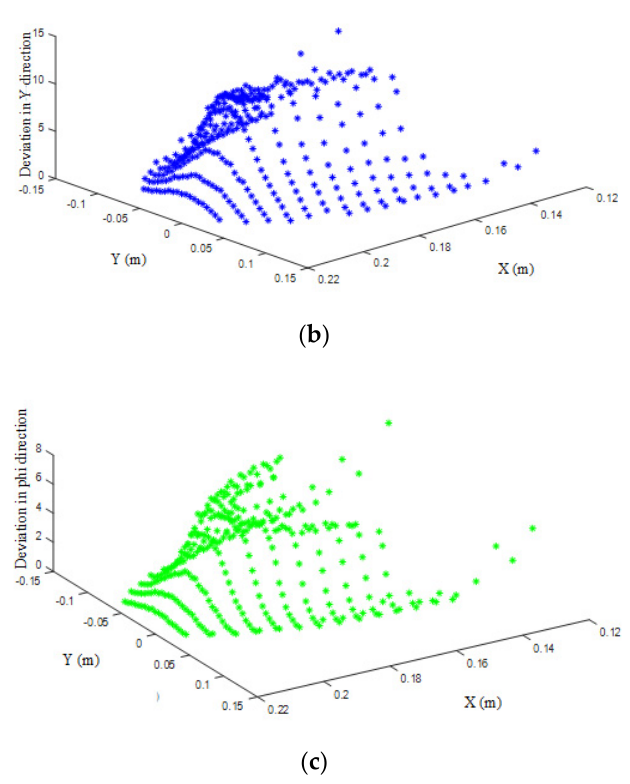
Figure 7. The influence of the random composite error on the tip positioning accuracy. ( a ) The influence of the cable length error on the tip in the X direction; ( b ) the influence of the cable length error on the tip in the Y direction; ( c ) the influence of the cable length error on the tip in the phi direction.